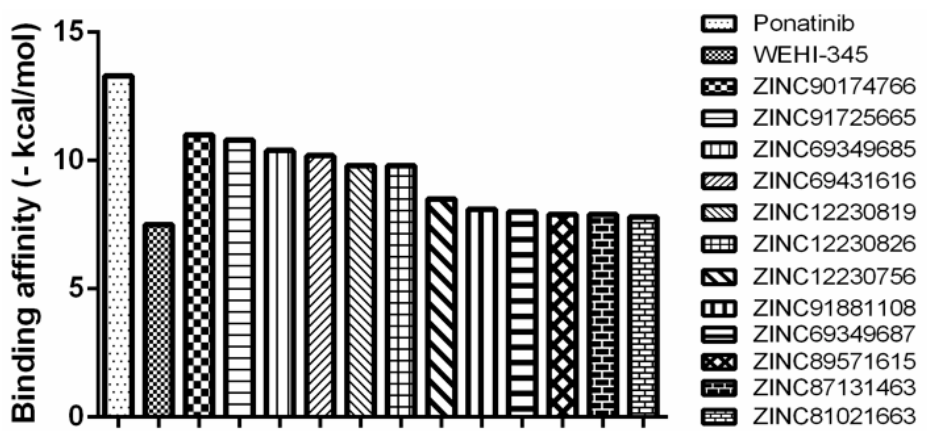
Figure 6. Binding affinity provided by the AutoDock/Vina software for the potent RIPK2 inihibitor and here used as a template—ponatinib, as well as for the control compound—WEHI-345 and the compounds obtained using a virtual screening approach, regarding RIPK2.